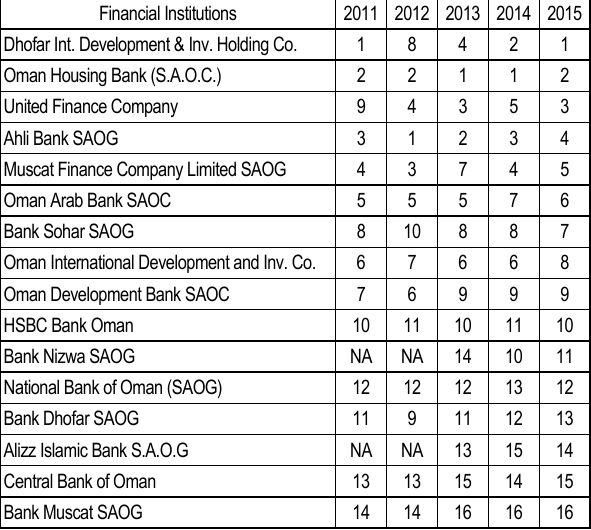
Table 3. All ranked results for financial institutions from 2011 to